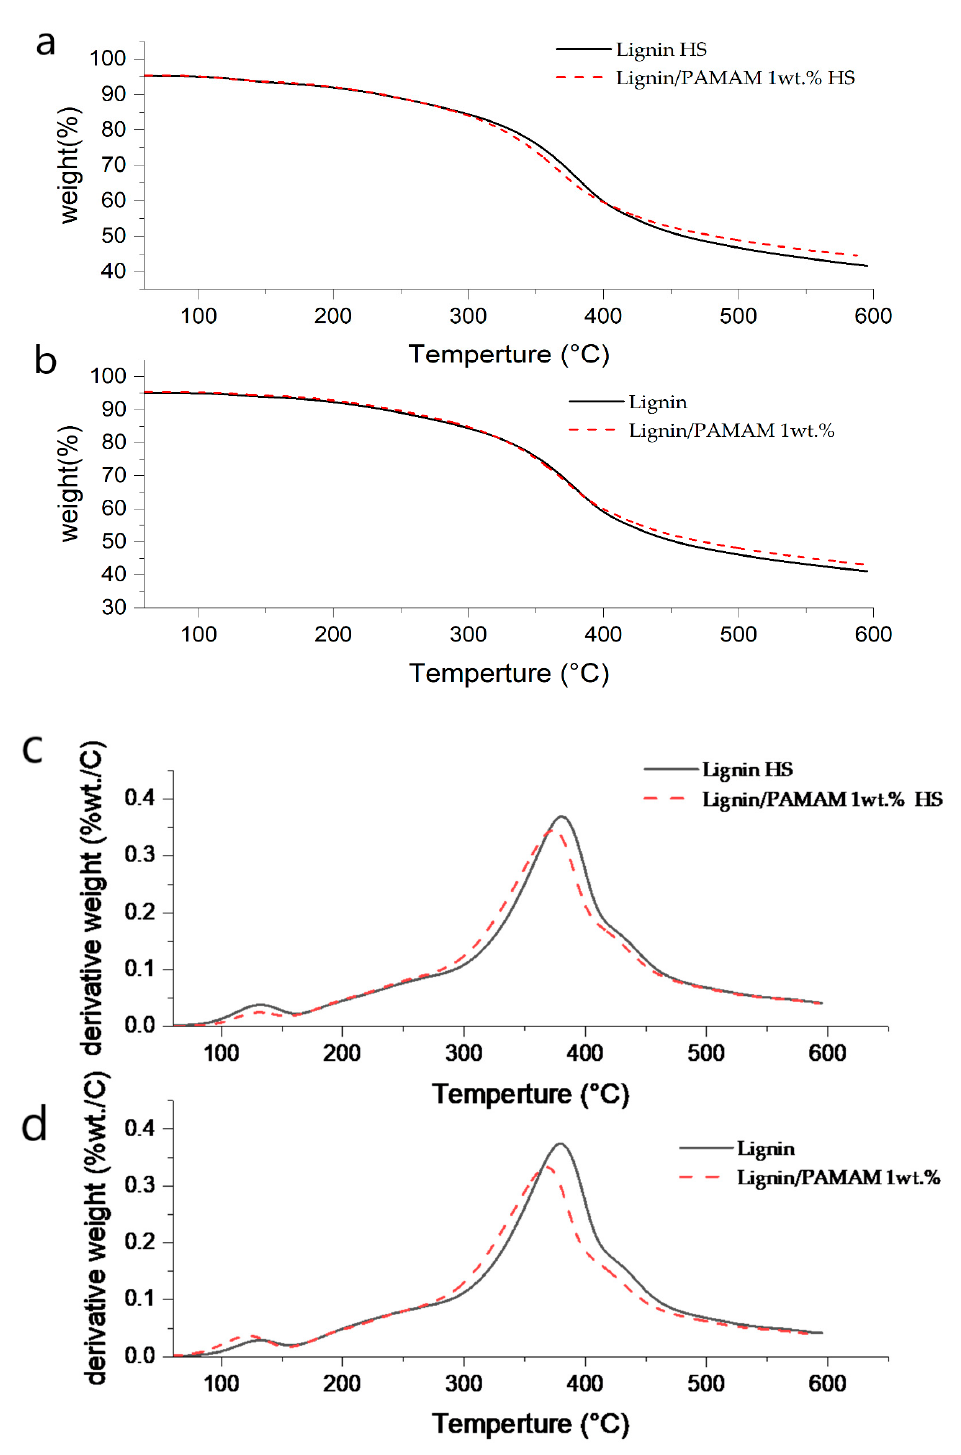
Figure 5. The TG of ( a ) Heatset (HS) samples, ( b ) untreated samples, and DTG of ( c ) Heatset (HS) samples, ( d ) untreated samples curves of the lignin and lignin/PAMAM dendrimer, under untreated and heat-set (HS) states.